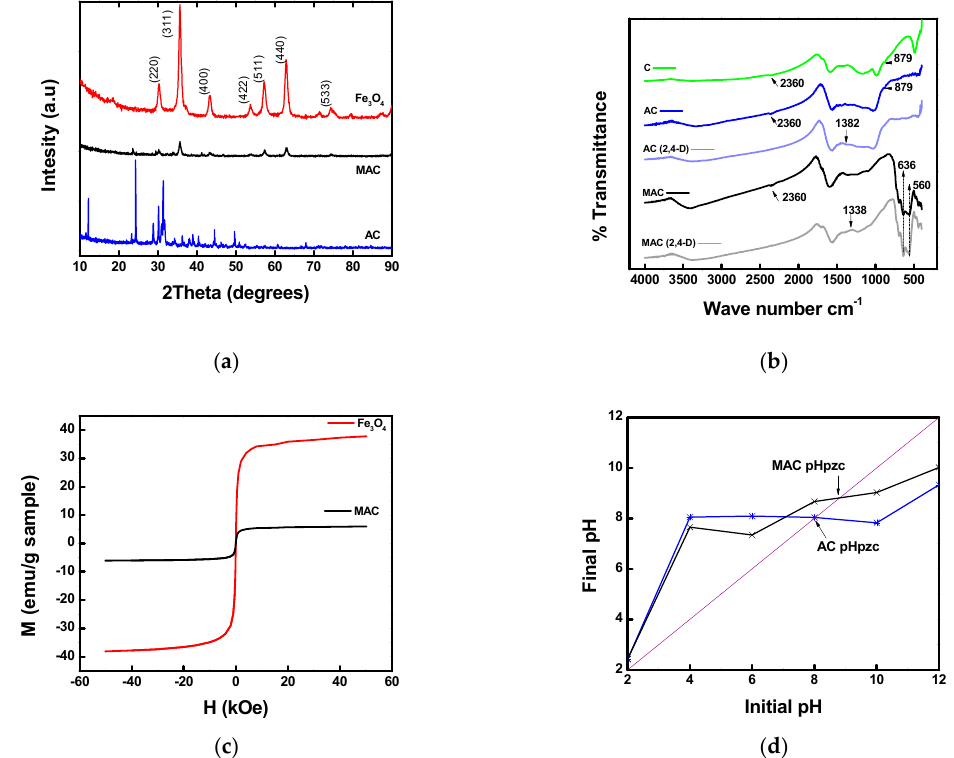
Figure 2. ( a ) XRD patterns of samples; ( b ) FTIR spectra of samples, 2,4-dichlorophenoxyacetic acid (2,4-D) after adsorption of pesticide; ( c ) Hysteresis loop for MAC and Fe 3 O 4 ; ( d ) Determination of the point of zero charge (pHpzc).